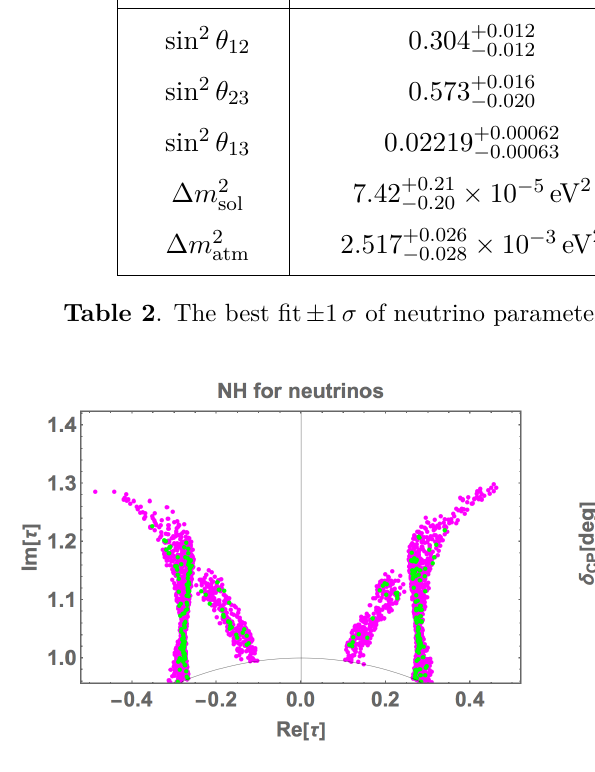
Figure 2 . Prediction of Dirac phase δ CP ver- sus Re [ τ ] for NH. There are six regions, which are almost symmetric with respect to the point ( Re [ τ ] = 0 , δ CP = 180 ◦ ). Colors denote same ones in figure